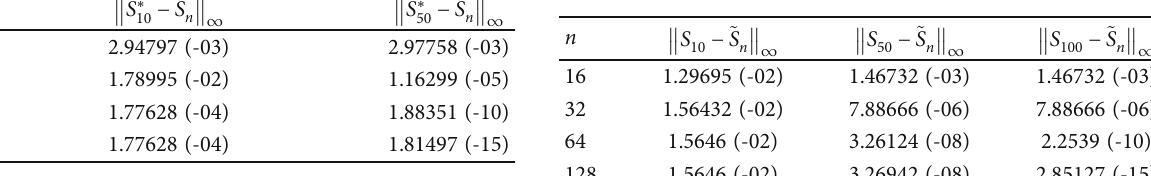
Table 4: Error norms between S ~ . S n